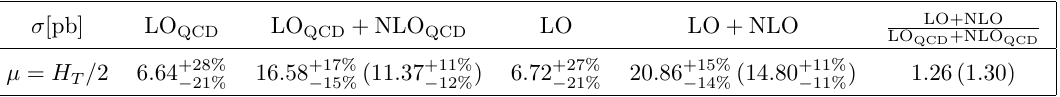
Table 2 . Same as in table 1 but for 100